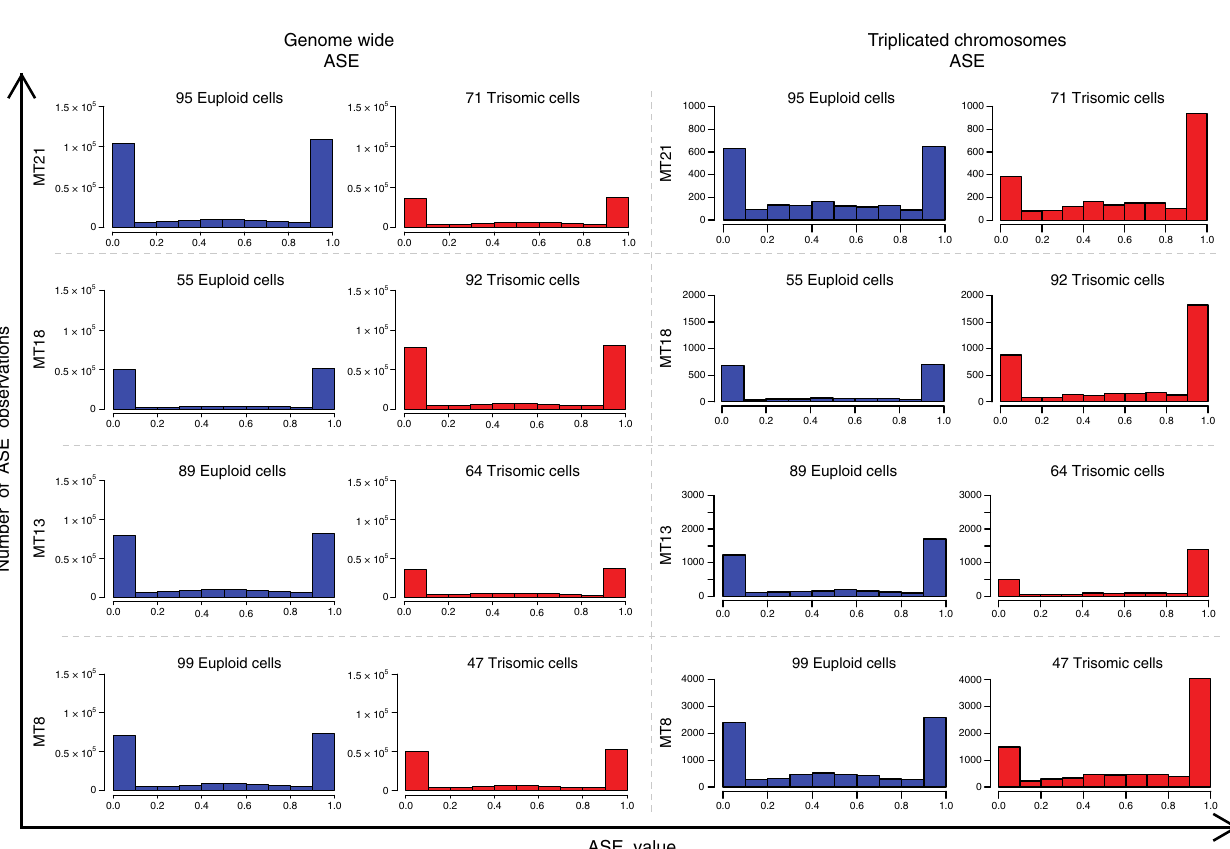
Fig. 2 Histogram of SC ASE observations in individuals mosaic for different trisomies. Each row represents one mosaic individual. Left Panel: Histogram of genome-wide ASE observations in SC excluding supernumerary chromosomes. High prevalence of monoallelic ASE observations was observed in all groups. Right panel: Histogram of ASE observations in SC in the supernumerary chromosomes. In all supernumerary chromosomes monoallelic ASE observations represent again the higher fraction of ASE observations, similarly to Genome Wide observations. In the trisomic group, monoallelic observations on supernumerary chromosomes for double allele (0.9 – 1) are proportionally higher than monoallelic observations of the single allele (0-0.1). Moreover the distribution of the biallelic observations in trisomic single cells is not centered as in diploid single cells, but shifted towards the double allele. (Blue = diploid, Red = trisomic). MT = Mosaic Trisomy. Source data are provided in the public